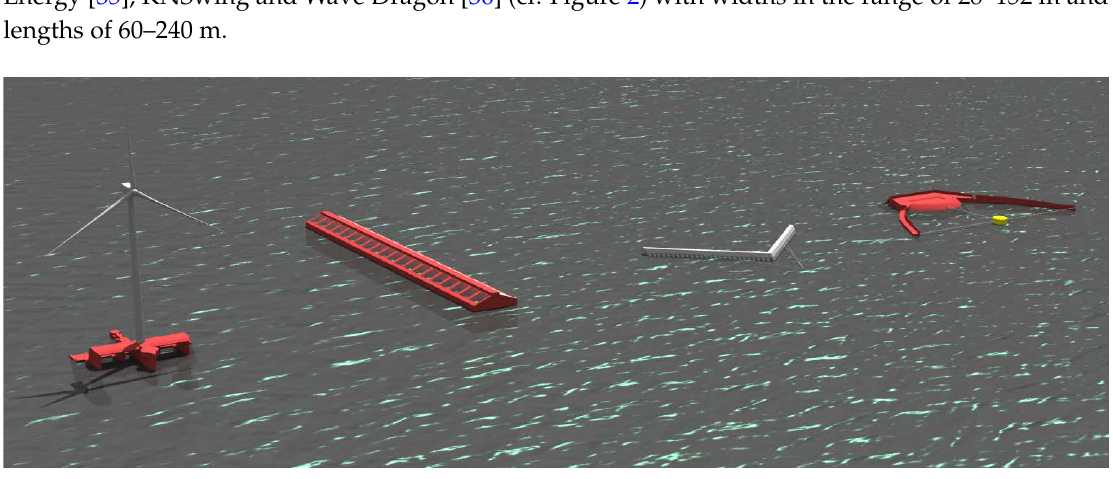
Figure 2. Examples of large floating WECs. From left to right: Floating Power Plant, KNSwing, LEANCON Wave Energy and Wave Dragon.